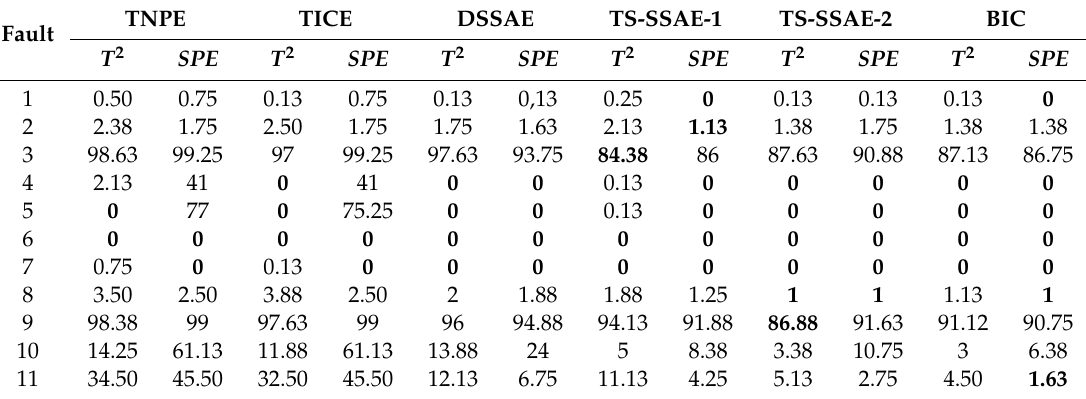
Table 4. Results of 21 faults detection in the Tennessee-Eastman process (MAR) /